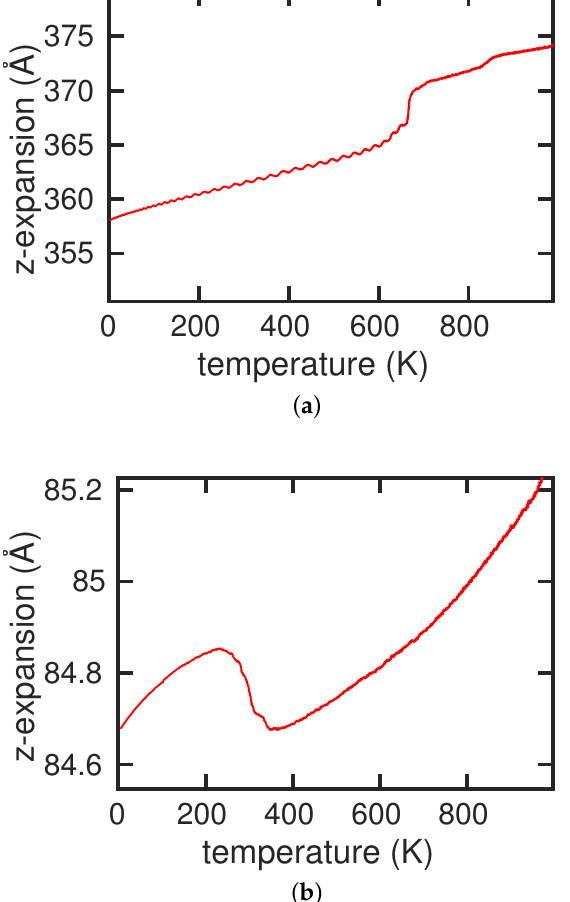
Figure 5. Variation in the length of the simulation volume in z direction (perpendicular to the interface plane) with temperature for: ( a ) the austenitic transformation; and ( b ) the martensitic